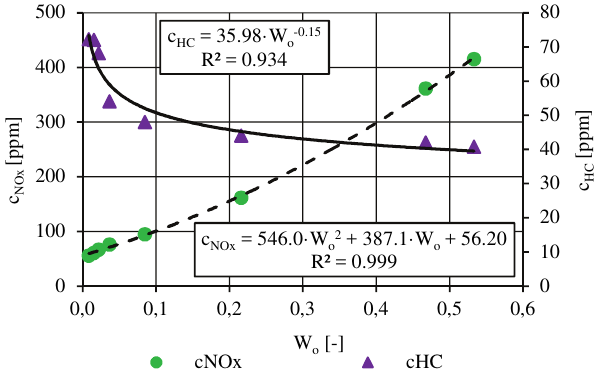
Fig. 6. Concentration of nitrogen oxides (c NOx ) and hydrocarbons concen- tration (c HC ) in the LM 2500 1A engine exhaust as a function of the engine load factor (W o )